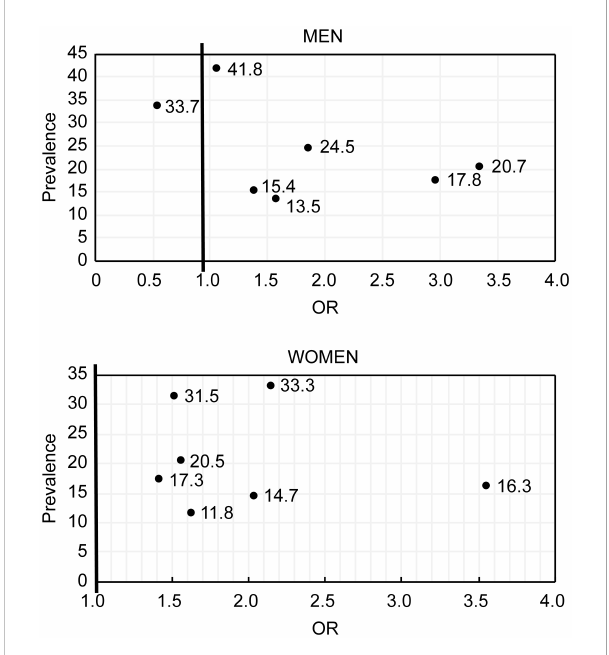
FIGURE 1 The relationship between the prevalence of risk factors and IGR incidence in men (Ain diagram) and women (top